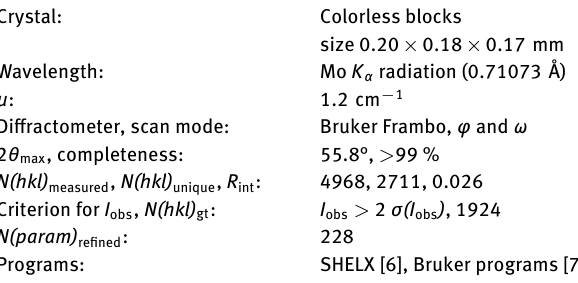
Table 2: Fractional atomic coordinates and isotropic or